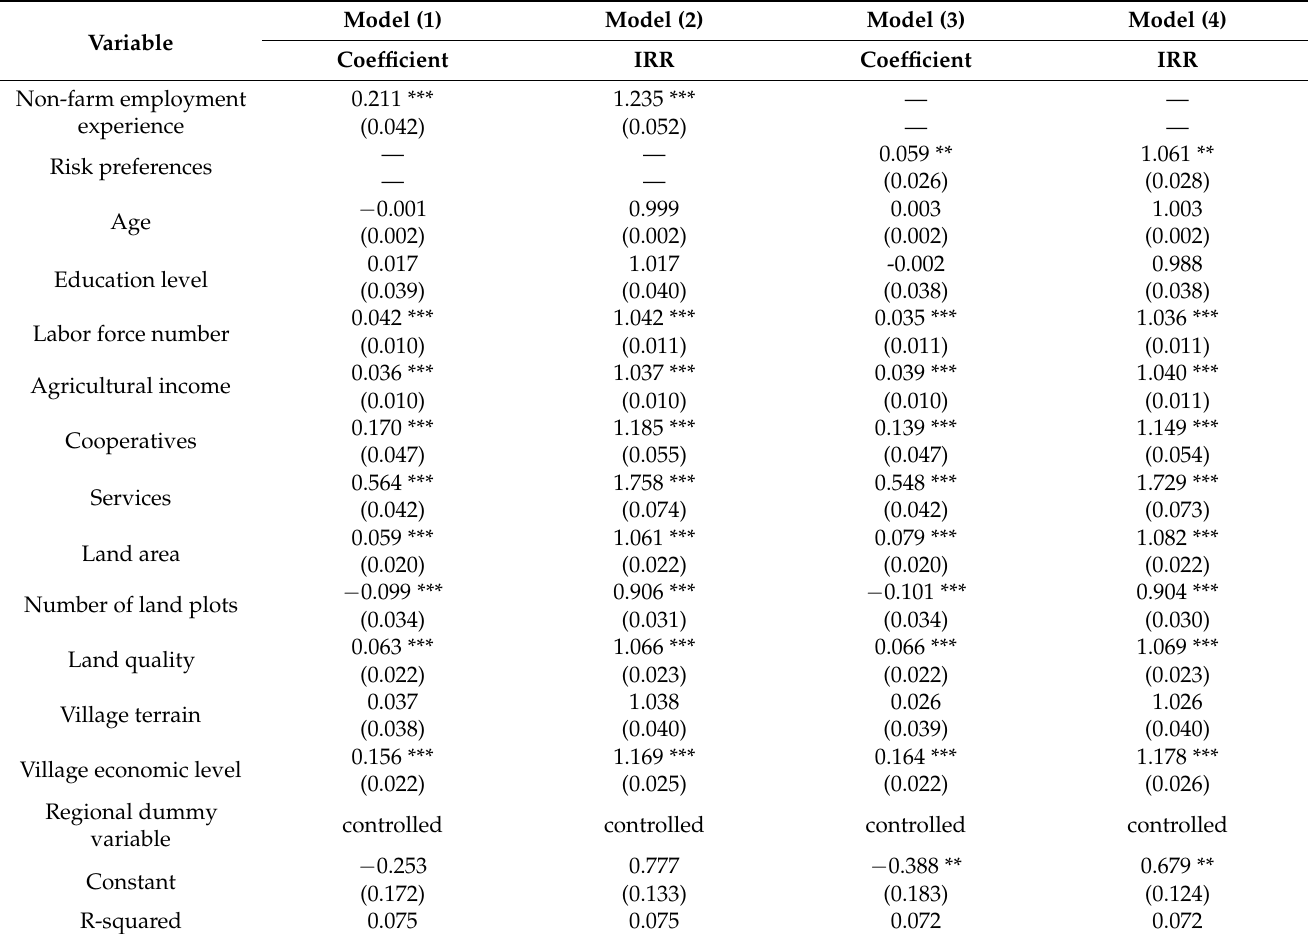
Table 3. Non-farm employment experience impact on grain farmers’ LCAT